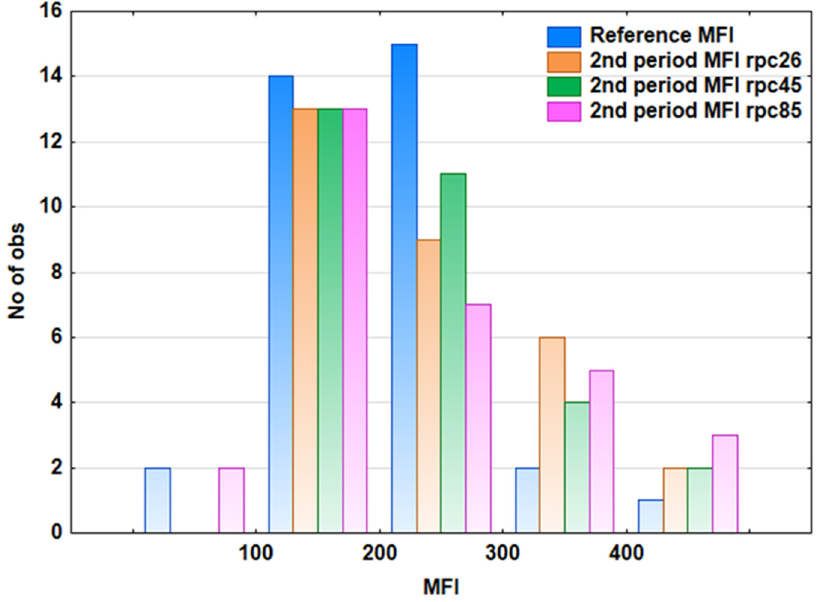
Figure 14. Distribution of MFI values in the reference period and the second-period climate sce- narios .